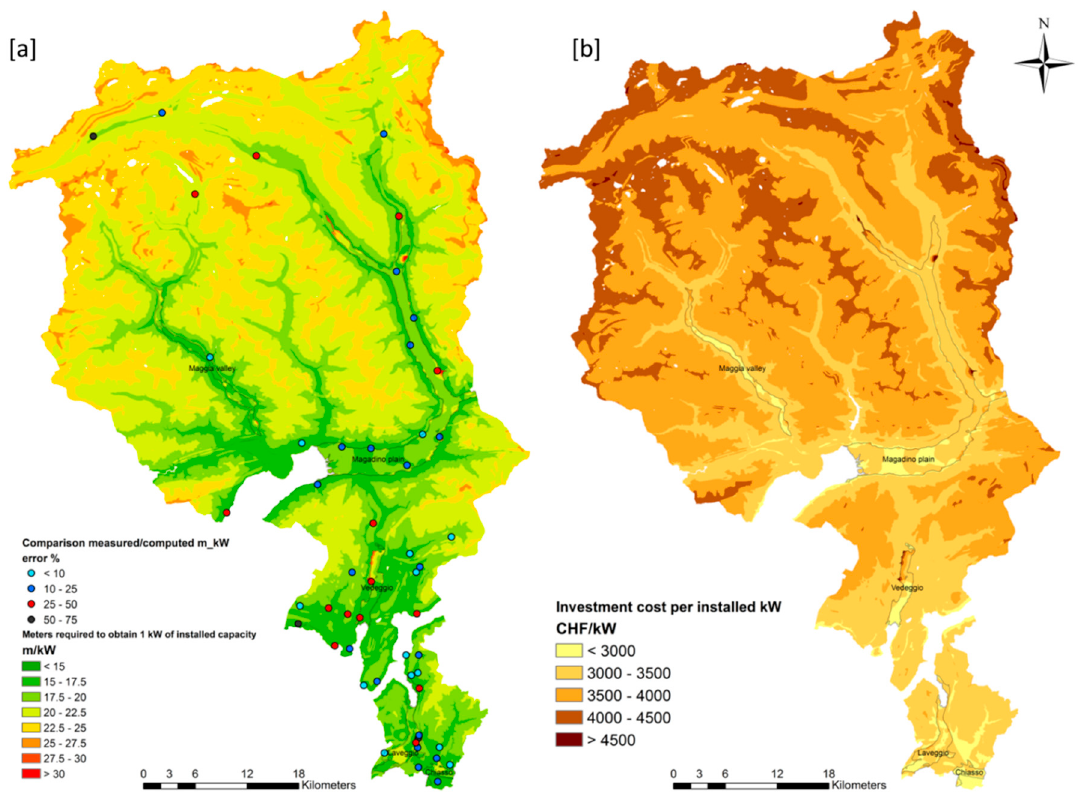
Figure 6. Map of ( a ) estimated meters required to obtain 1 kW of installed power and ( b ) specific capital cost expressed as CHF/kW. Table 8. Comparison statistics between measured and computed borehole heat exchanger (BHE) lengths.